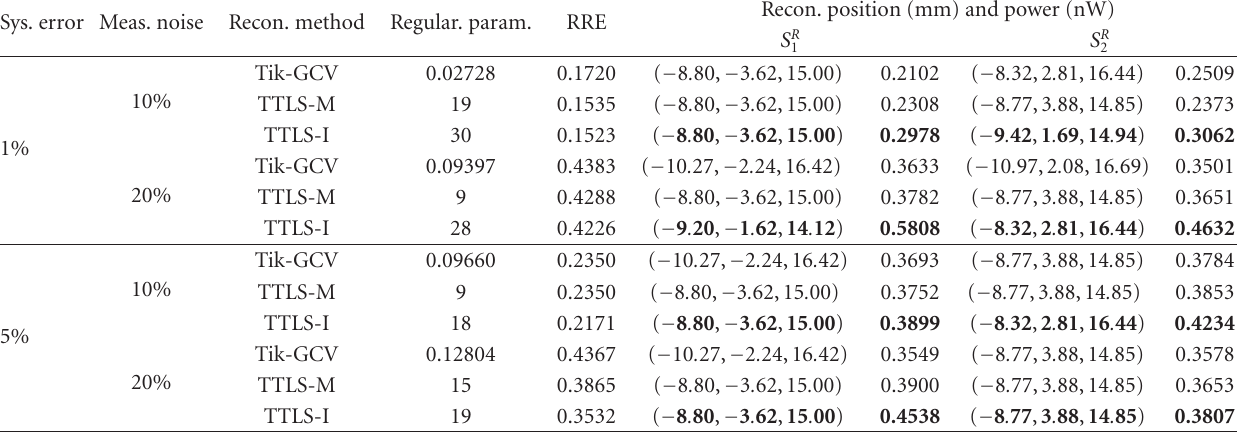
Table 4: Quantitative results for ball shape permission region PR (cid:4) in double source case. Sys. error Meas.